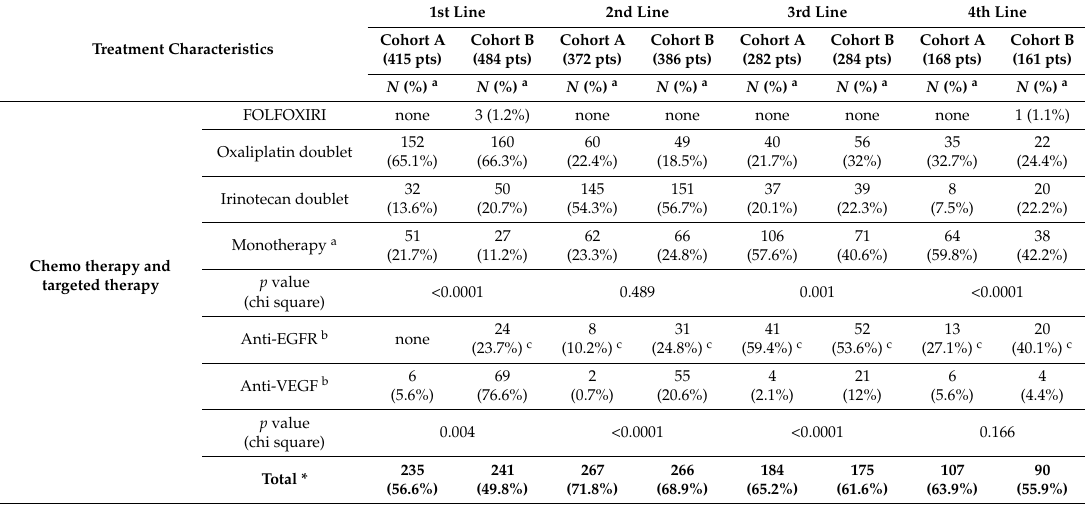
Table 4. Treatment